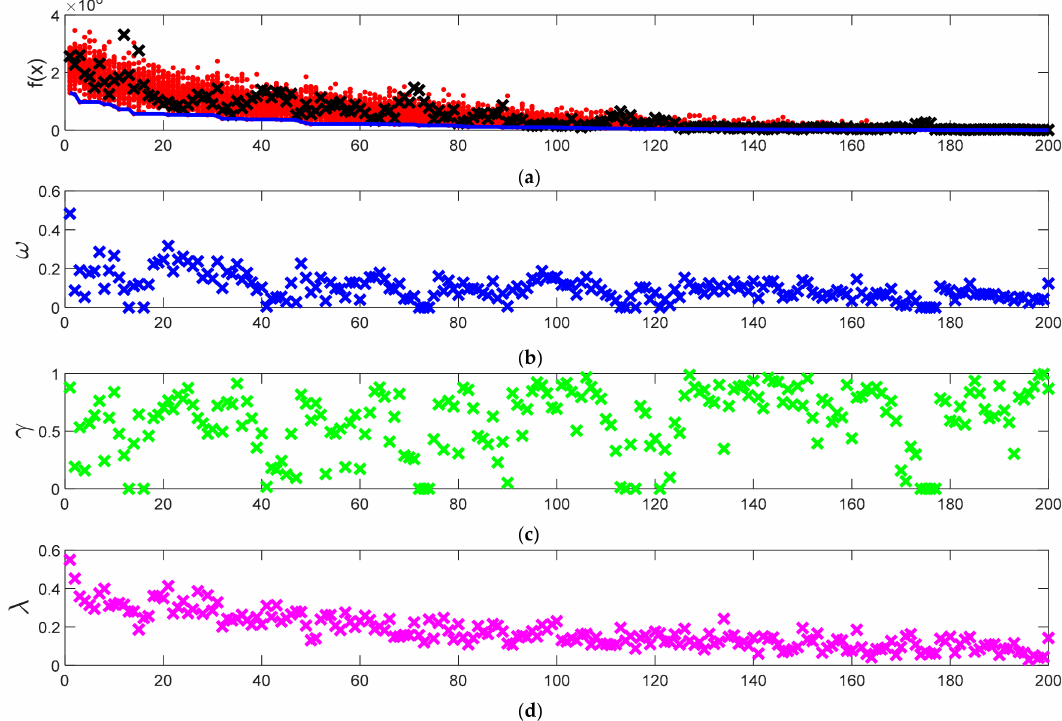
Figure 2. Sample constant values of a single particle during the first 200 iterations of f20 Trigonometric 2. ( a ) x shows the function value of a selected random particle with the other particles (in red), the blue line indicates the best value. The values of this particle’s ω , γ , and λ are shown in ( b – d ),